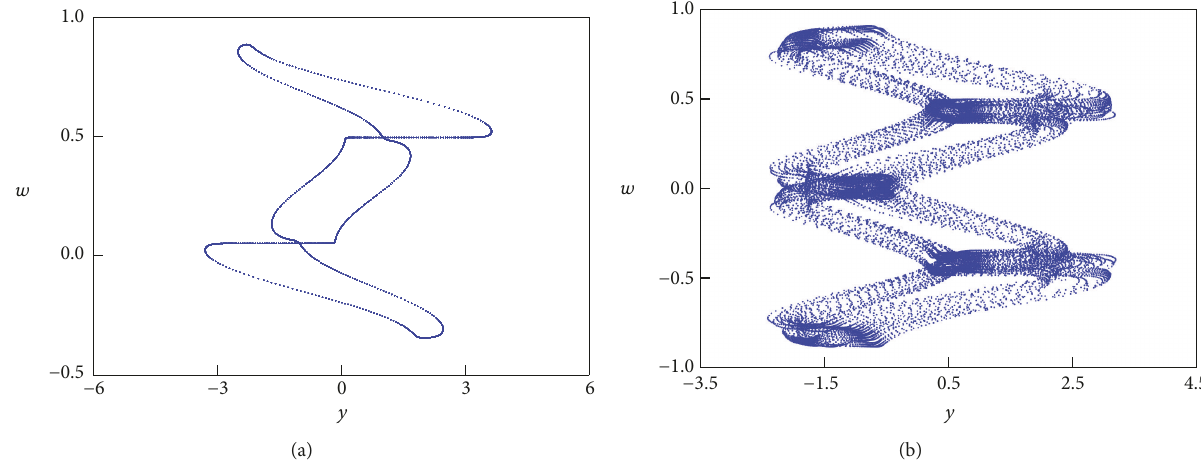
Figure 3: Phase diagrams of different system parameters 𝜉 : (a) 𝜉 = 1.44 and (b) 𝜉 = 1.68 .